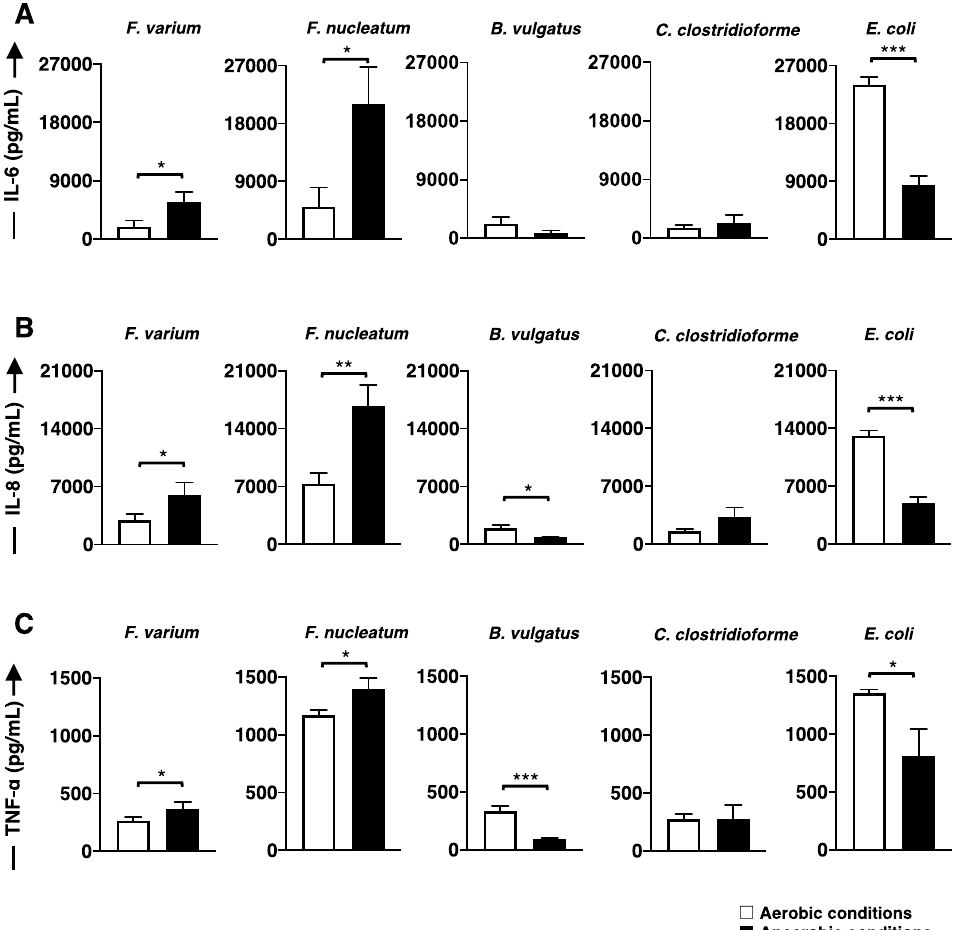
Figure 8. Comparison of the proinflammatory cytokines produced by the DC line stimulated with live commensal bacteria between aerobic and anaerobic conditions. The DC line was stimulated with live commensal bacteria under aerobic (white bar) or anaerobic (black bar) conditions for 4 h. Thereafter, the DC line was cultured for an additional 20 h (total of 24 h) under aerobic culture conditions. IL-6, IL-8, or TNF-α production by the DC line represents the results of three independent experiments. The commensal bacteria used in this study are as follows: Fusobacterium varium ( F. varium ), Fusobacterium nucleatum ( F. nucleatum ), Bacteroides vulgatus ( B. vulgatus ), Clostridium clostridioforme ( C. clostridioform e), and Escherichia coli ( E. col i). A t test was used to compare the levels of proinflammatory cytokines produced by the DC line stimulated with commensal bacteria under aerobic or anaerobic stimulation conditions. * p < 0.05, ** p < 0.01, and *** p <